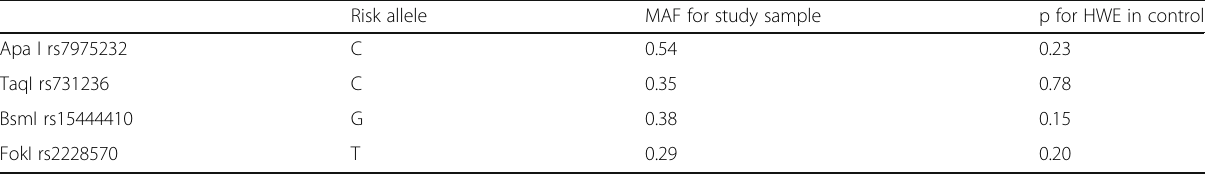
Table 2 Minor allele frequency and Hardy-Weinberg Equilibrium of VDR gene SNPs Risk allele MAF for study sample p for HWE in control